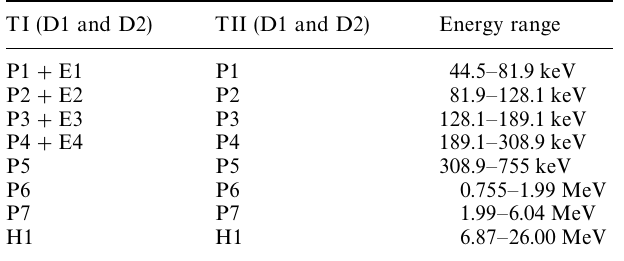
Table 1. LION energy channels TI (D1 and D2)